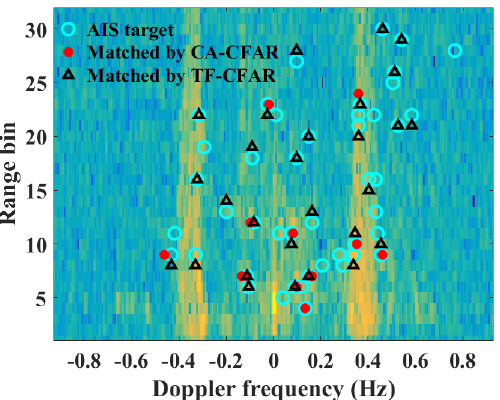
Figure 6. CFAR, TF-CFAR, and AIS target-matching RD map at 06:51 on 25 September 2015.